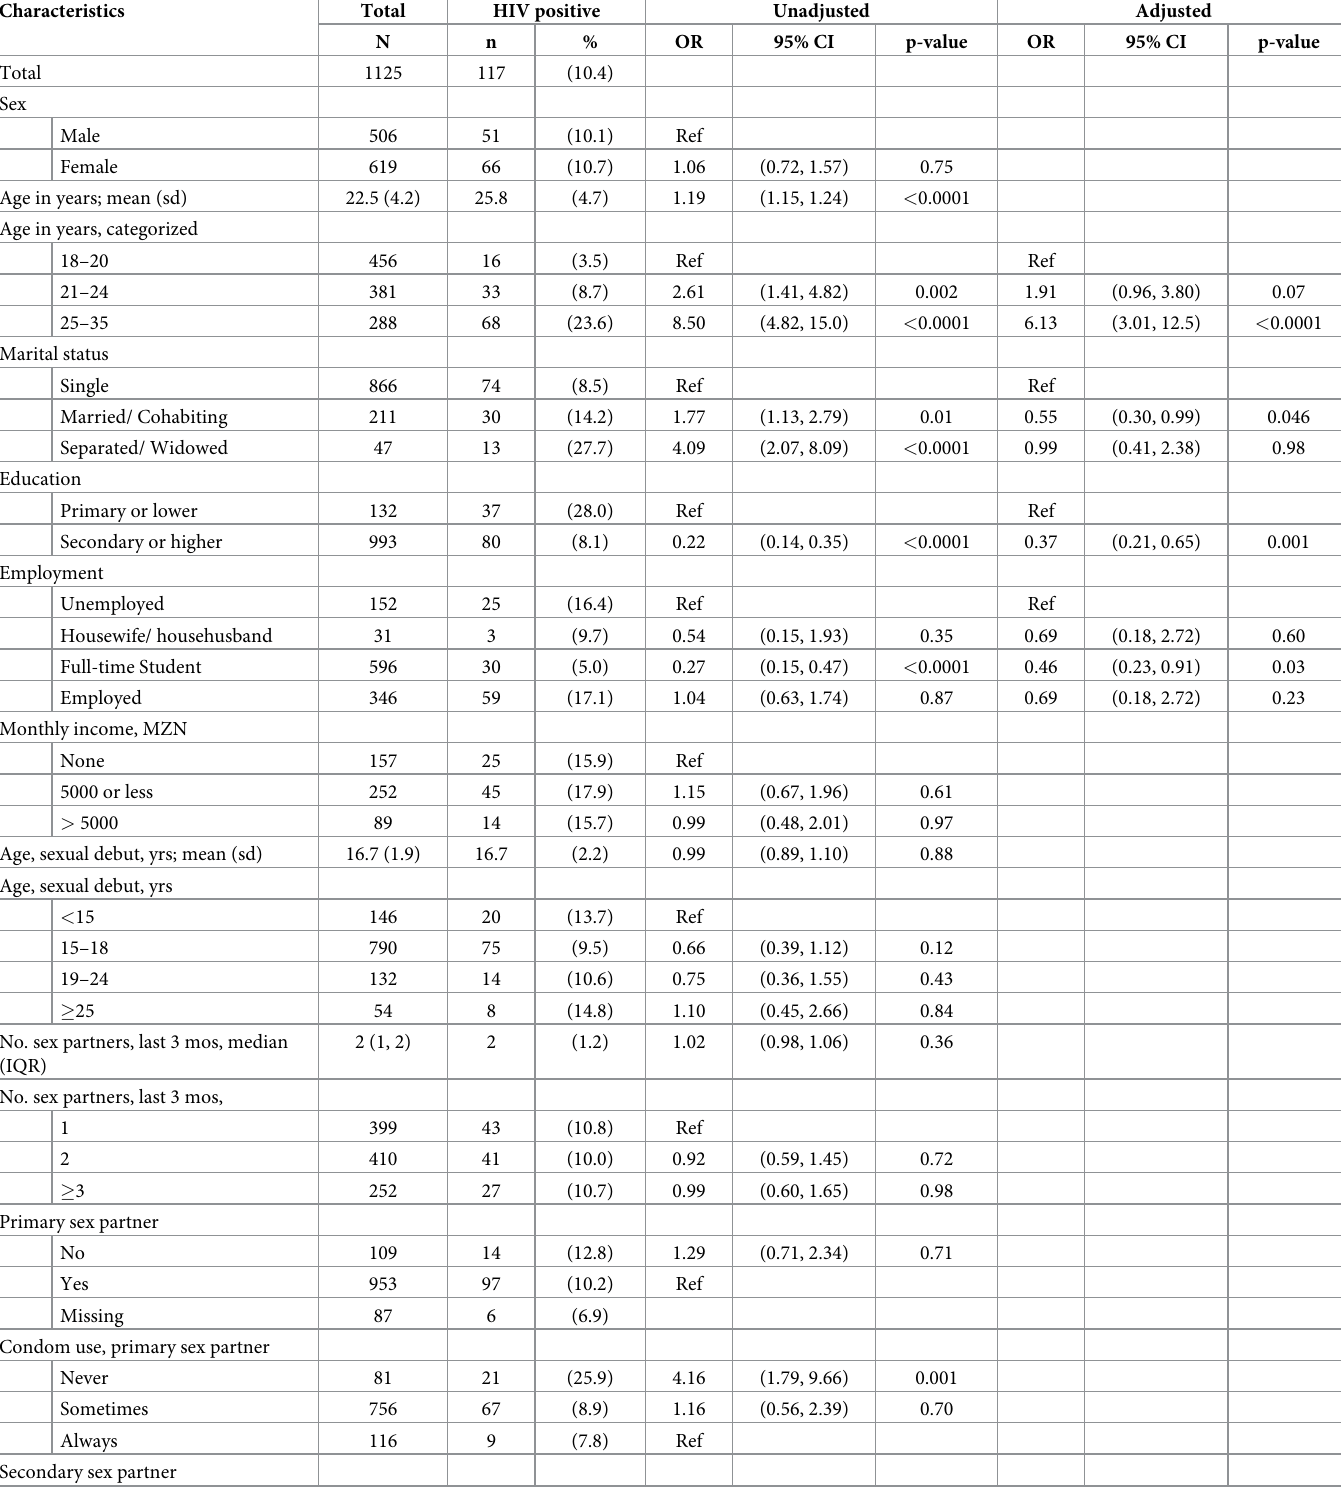
Table 2. Risk factors associated with HIV infection among adults screened from 2013–2014 for enrolment in a vaccine preparedness trial, Maputo city, Mozam- bique (N = 1125).